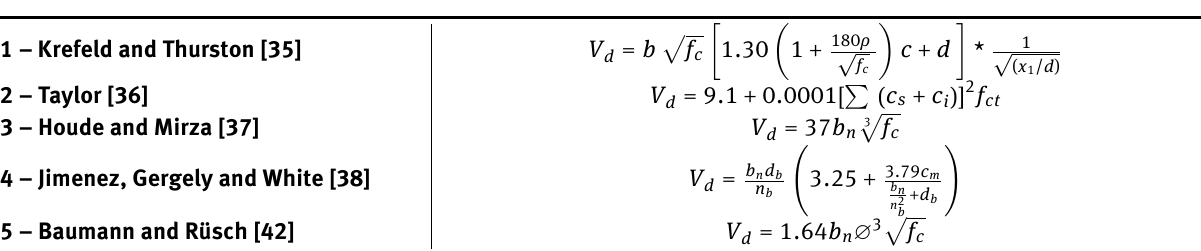
Table 5: Some equations for prediction of the dowel